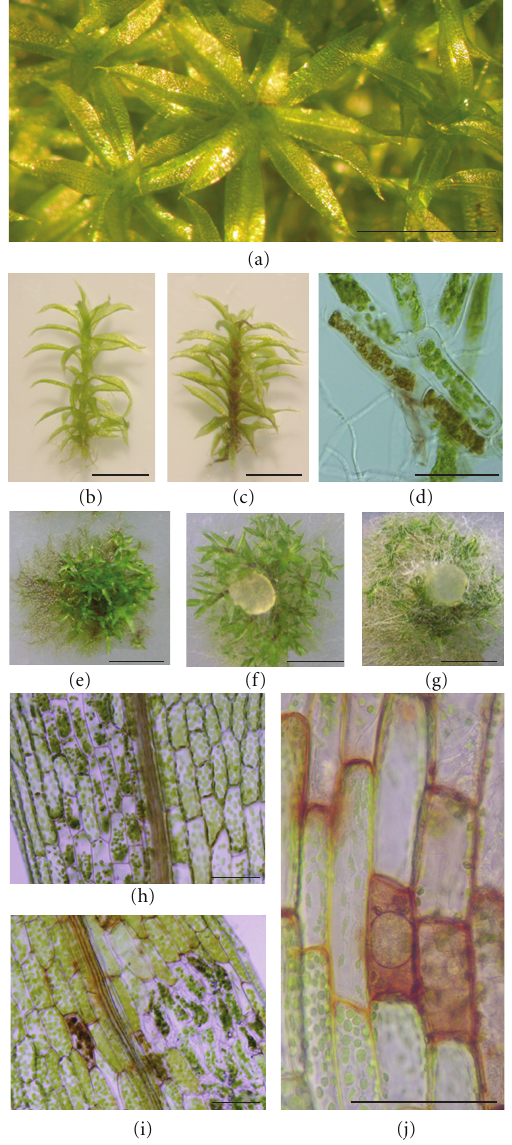
Figure 1: Disease symptoms in pathogen-infected moss tissues. (a) Healthy gametophytes, (b) Healthy gametophore, (c) P. irregulare - inoculated gametophore, (d) B. cinerea -inoculated protonema fil- aments, (e) B. cinerea -inoculated moss colony, (f) P. irregulare - inoculated colony, (g) P. irregulare -inoculated colony showing my- celium covering plant tissues, (h) P. irregulare -inoculated leaf, (i) B. cinerea inoculated leaf, (j) P. debaryanum -inoculated leaf showing an oospore. The scale bar represents 0.9 mm (a–c), 4mm (e–g), and 20 μ m (d, h–j).